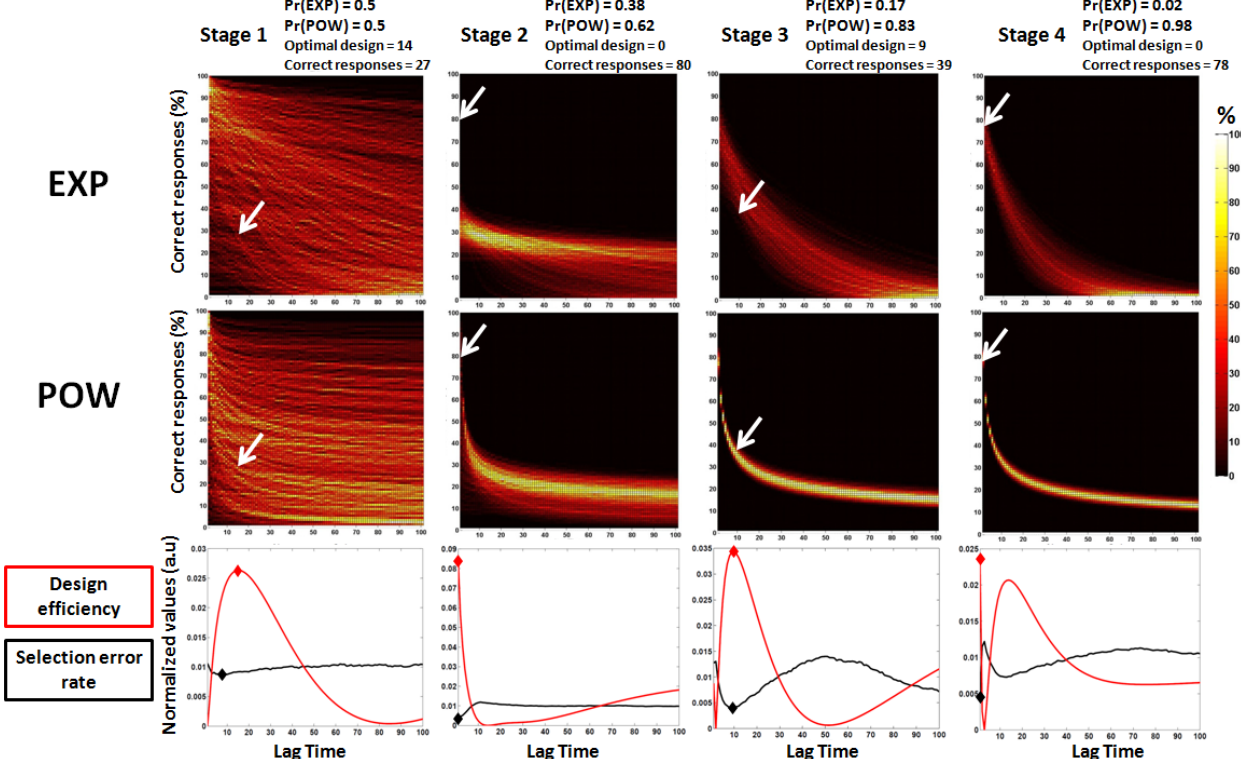
Figure 3. Predictions of the power (POW) and exponential (EXP) models in the first four stages of one simulated experiment and the landscape of selection error rate across lag time. The predictions are based on the prior parameter estimates at each stage. The text above and inside the graphs provides information about the prior probabilities of each model, the optimal designs for discriminating the models and the observed outcomes (correct responses) at each stage of the simulated experiment. Arrows denote the percentage of correct responses at the optimal lag time. For the heat maps of models predictions ( top and middle panels), yellow colors indicate regions of higher probability. ( Bottom ) The bottom panel, represents the error selection rate for each possible lag time (normalized values of arbitrary units, black line ), as well as the estimated efficiency ( red line ), which is our main criterion. At each stage, we choose the maximum of our criterion ( red diamond ), which mostly coincides (because of the approximation) with the minimum of the error selection rate ( black diamond